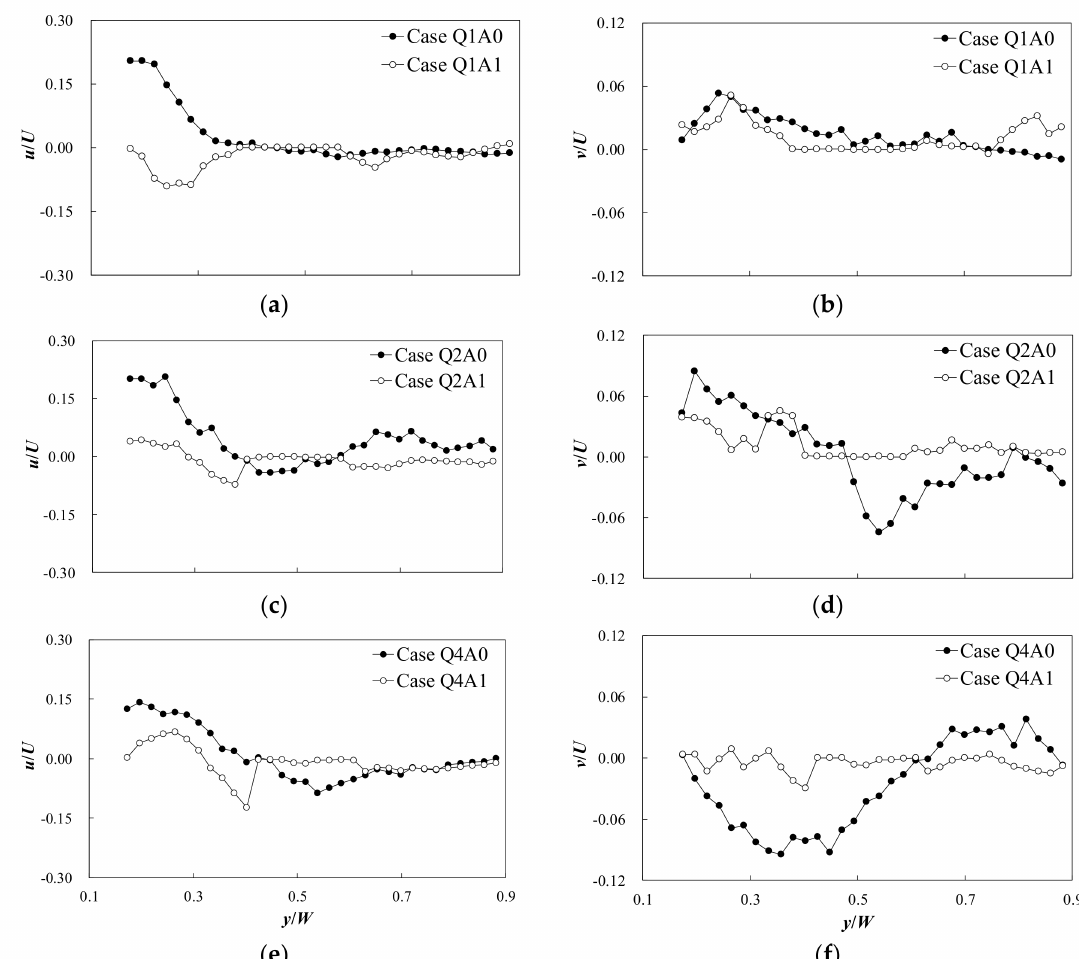
Figure 11. Velocity distributions behind the intake pipe at z / h = 0.9: ( a ) u -velocity ( Q = 0.018 m 3 /s); ( b ) v -velocity ( Q = 0.018 m 3 /s); ( c ) u -velocity ( Q = 0.022 m 3 /s); ( d ) v -velocity ( Q = 0.022 m 3 /s); ( e ) u -velocity ( Q = 0.027 m 3 /s); and ( f ) v -velocity ( Q = 0.027 m 3